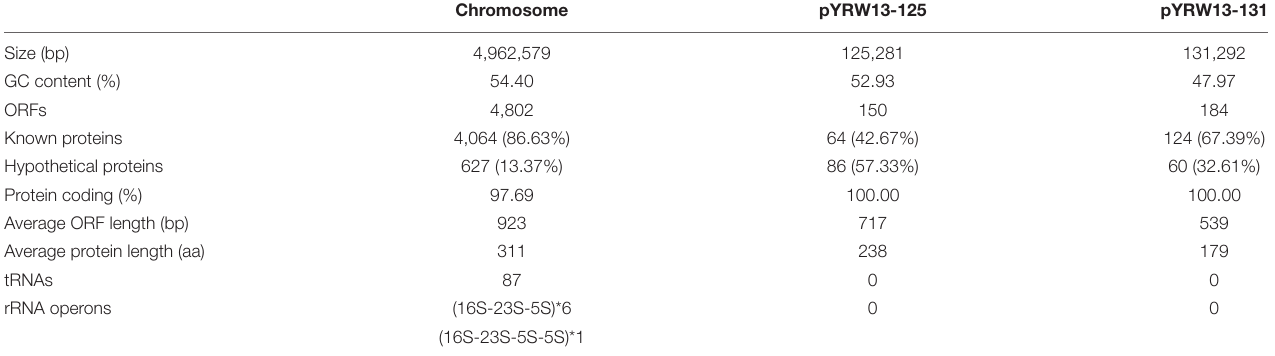
TABLE 3 | General features of the Y. regensburgei W13 genome.